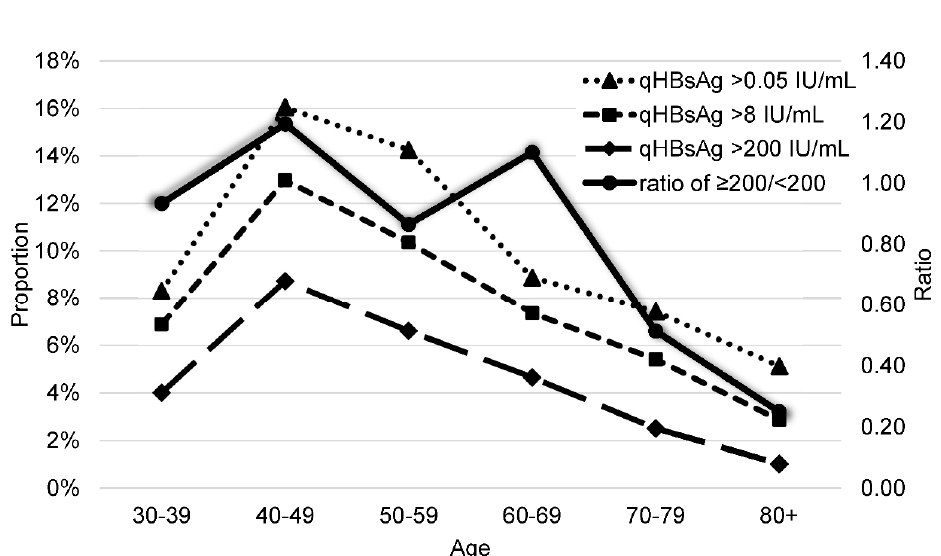
Figure 2. Age − specific prevalence of quantitative HBsAg by cutoffs of 0.05, 8, and 200 IU/mL. The ratio of ≥ 200/<200 was also shown.